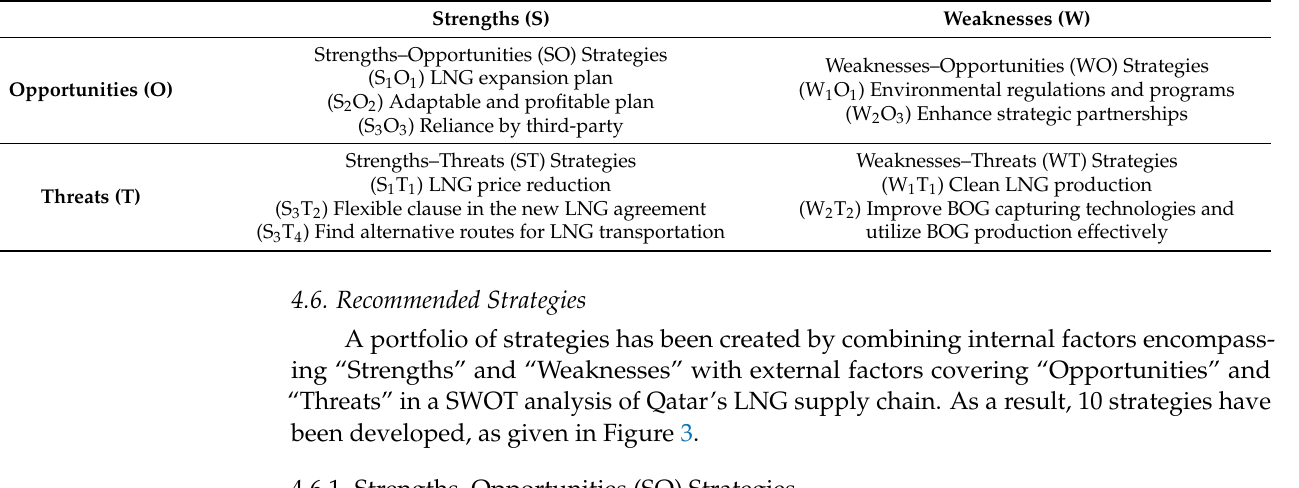
Table 3. SWOT matrix for the LNG supply chain of